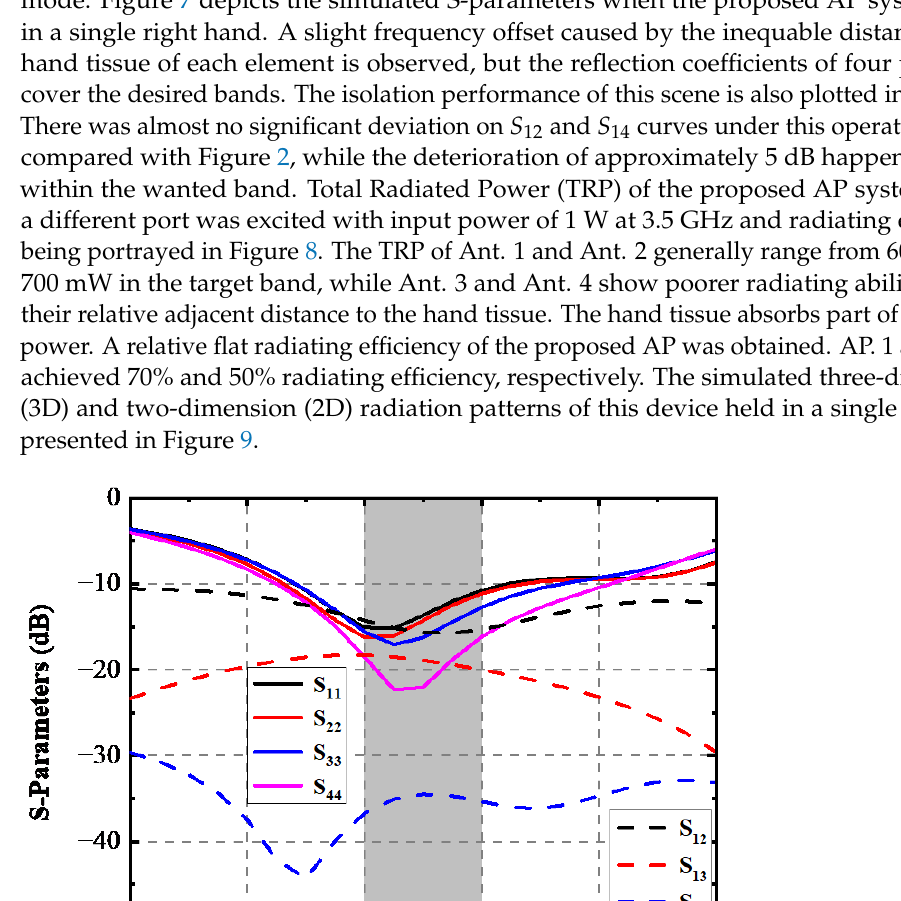
Figure 8. Simulated TRP and radiating efficiency of every antenna element. Figure 9. Simulated 3D and 2D radiating patterns of the proposed AP when Port 1 is excited at 3.5 GHz.